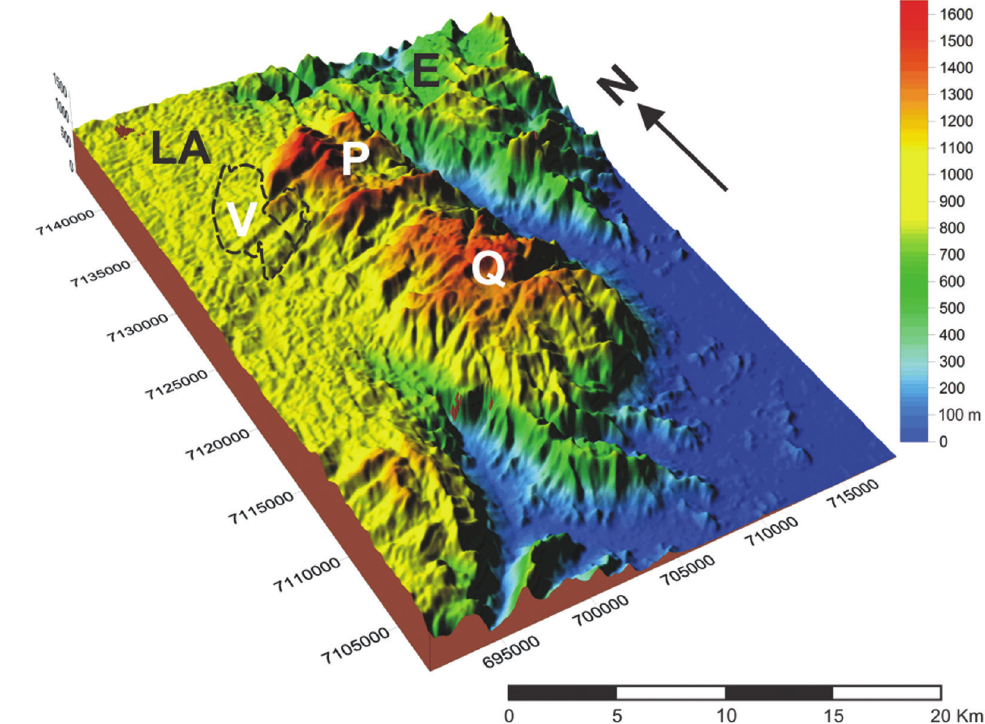
Figure 2 - SRTM 3D digital model for the Morro Redondo Complex and surrounding areas based on contour lines equidistant at 5 meters through mathematical interpolation using the software Global